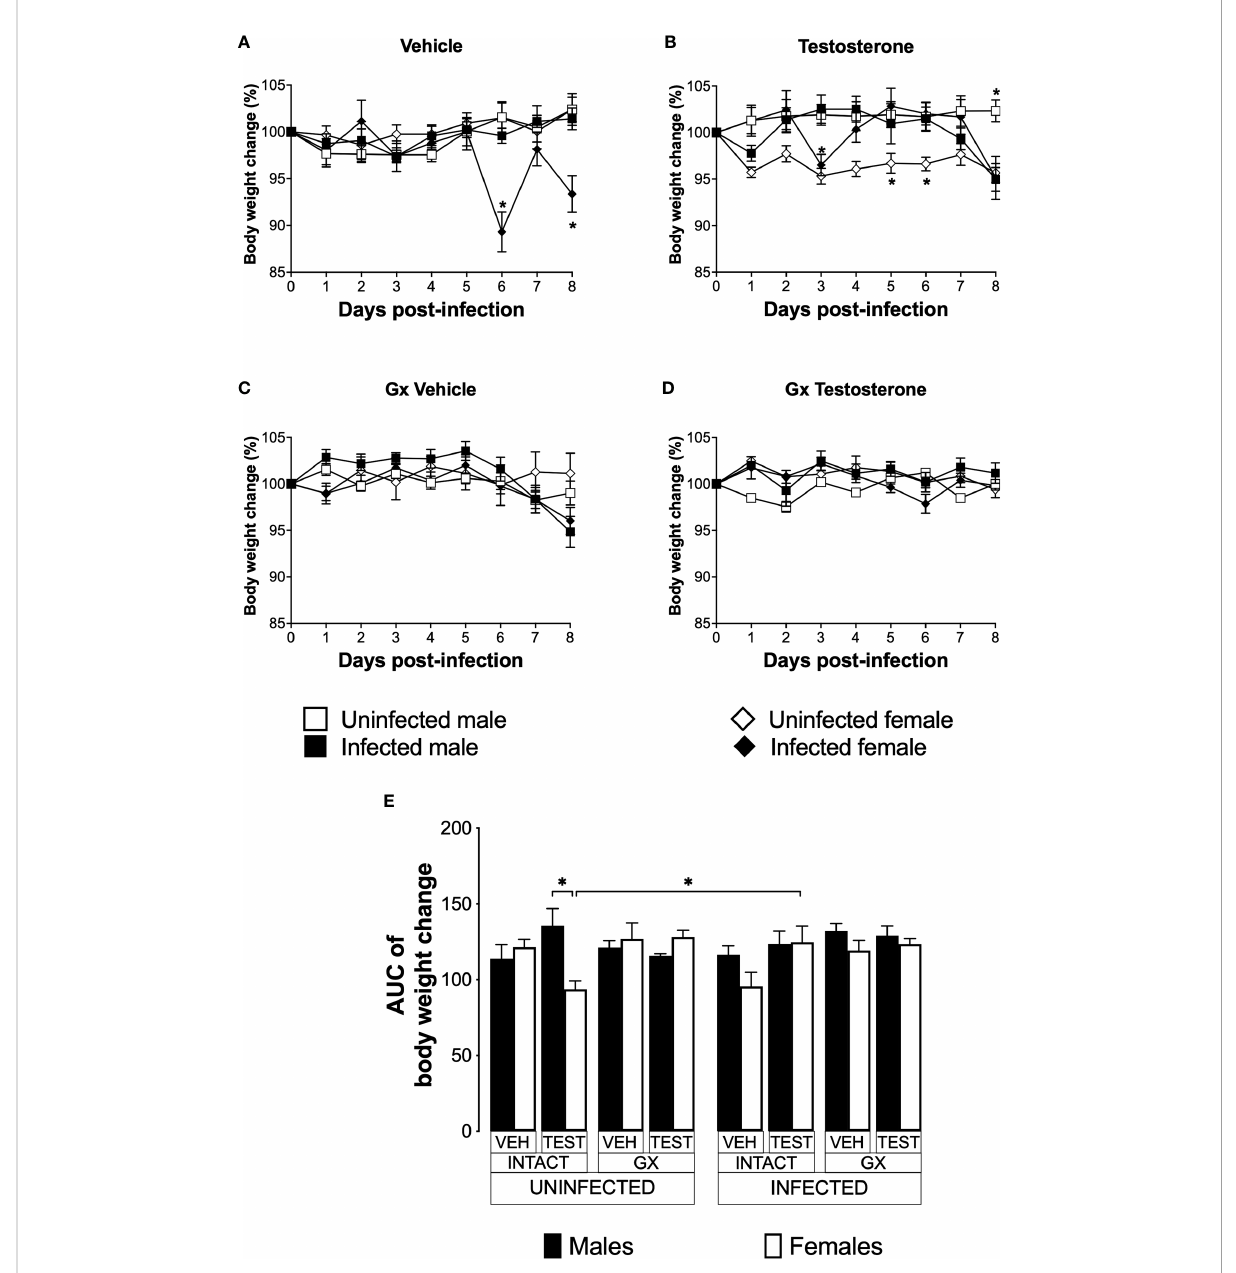
FIGURE 4 Testosterone increased body weight in female mice infected with P. berghei ANKA. We studied 8 groups of males and 8 groups of females, 4 groups of each sex were gonadectomised (GX), and the other 4 groups were left intact; four weeks after surgery, two groups of intact and two GX mice of each sex were administered testosterone for 3 weeks, the other two received vehicle for the same time. Finally, one intact and one GX group treated with testosterone of each sex were infected with P. berghei ANKA. The remaining groups were injected with PBS as negative infection controls. From the onset of infection, the percentage change in body weight was determined on the base of the body weight obtained at day zero of infection (100%). (A) shows the body weight change in intact male and female mice infected or uninfected with the parasite and treated with vehicle; (B) shows body weight change in testosterone-treated male and female intact mice groups; (C) shows body weight change in vehicle-treated GX groups infected or uninfected in both sexes; (D) shows body weight change in the testosterone-treated GX groups infected or uninfected. Asterisks (*) represent statistically signi fi cant differences between uninfected and infected groups, obtained by repeated means ANOVA with a Bonferroni post-hoc test p ≤ 0.05. Finally, (E) shows the area under the curve analysis (AUC) of the vehicle-treated (VEH), testosterone-treated (TEST), intact (INTACT), or gonadectomised (GX) groups. Mice infected with P. berghei ANKA (INFECTED) or uninfected (UNINFECTED). Each bar represents the mean ± SEM. Asterisks denote statistical signi fi cance between 2 groups (*) p < 0.05; calculated by Kruskal-Wallis analysis with Dunn ’ s post-hoc test. The whole experiment was conducted in duplicate (n =